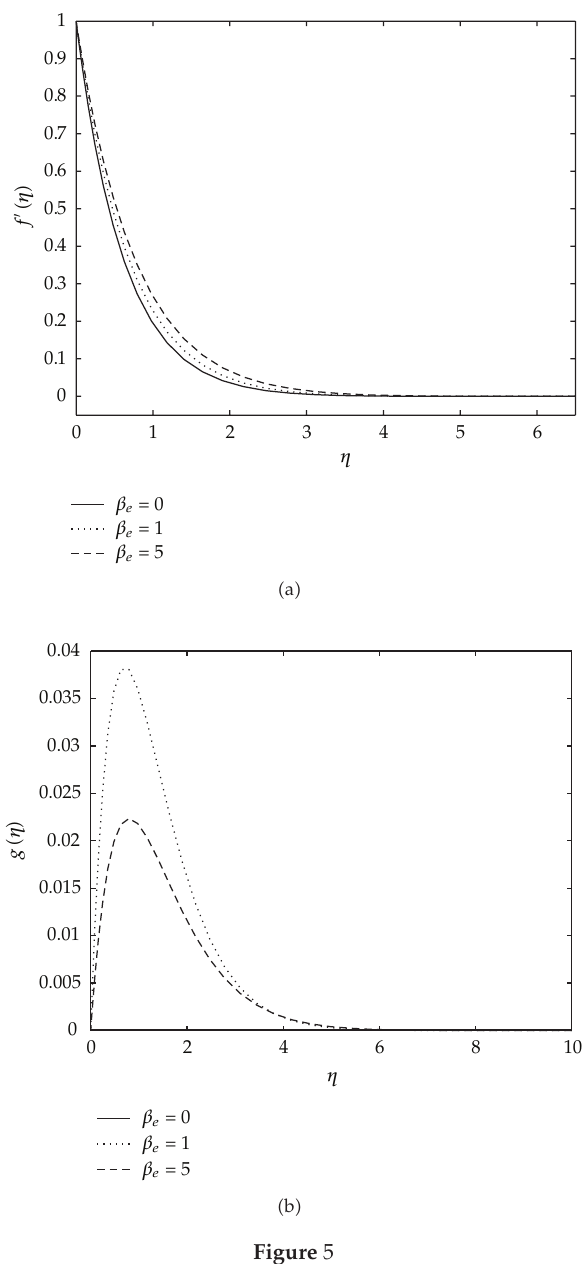
Figure 7 we have the influence of the magnetic field parameter on the lateral velocity. It can be seen that as the values of this parameter increase, the lateral velocity